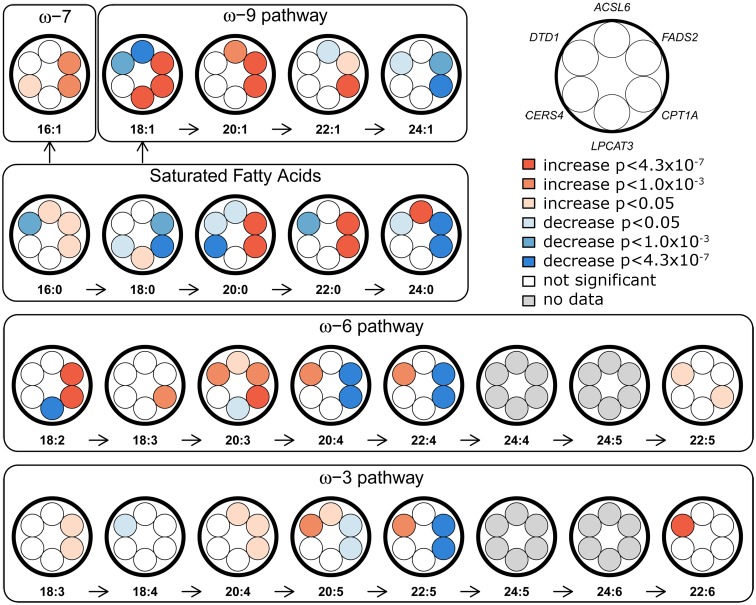
Overview of FA-synthesis pathways and candidate-SNP associations.Effects of candidate SNPs from the six identified erythrocyte membrane FA-associated loci are shown for each of the 22 assessed FAs. ACSL6, rs76430747; FADS2, rs174570; CPT1A, rs80356779; LPCAT3, rs2110073; CERS4, rs11881630; DTD1, rs6035106.